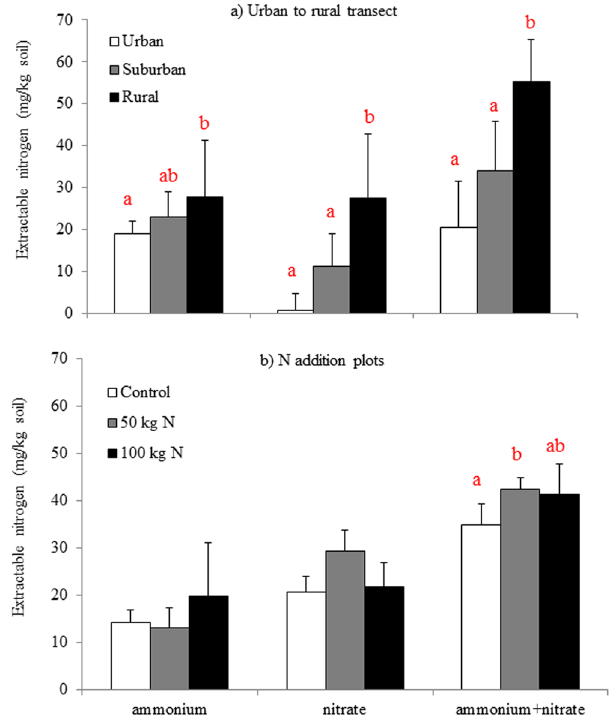
Figure 1. Soil KCl extractable nitrogen in the urban to rural transect ( a ) and the nitrogen addition plots ( b ). Error bars represent standard deviation. Letters represent significance at p < 0.05 from 1-way ANOVA followed by Tukey HSD (n = 5 for a and n = 3 for ( b